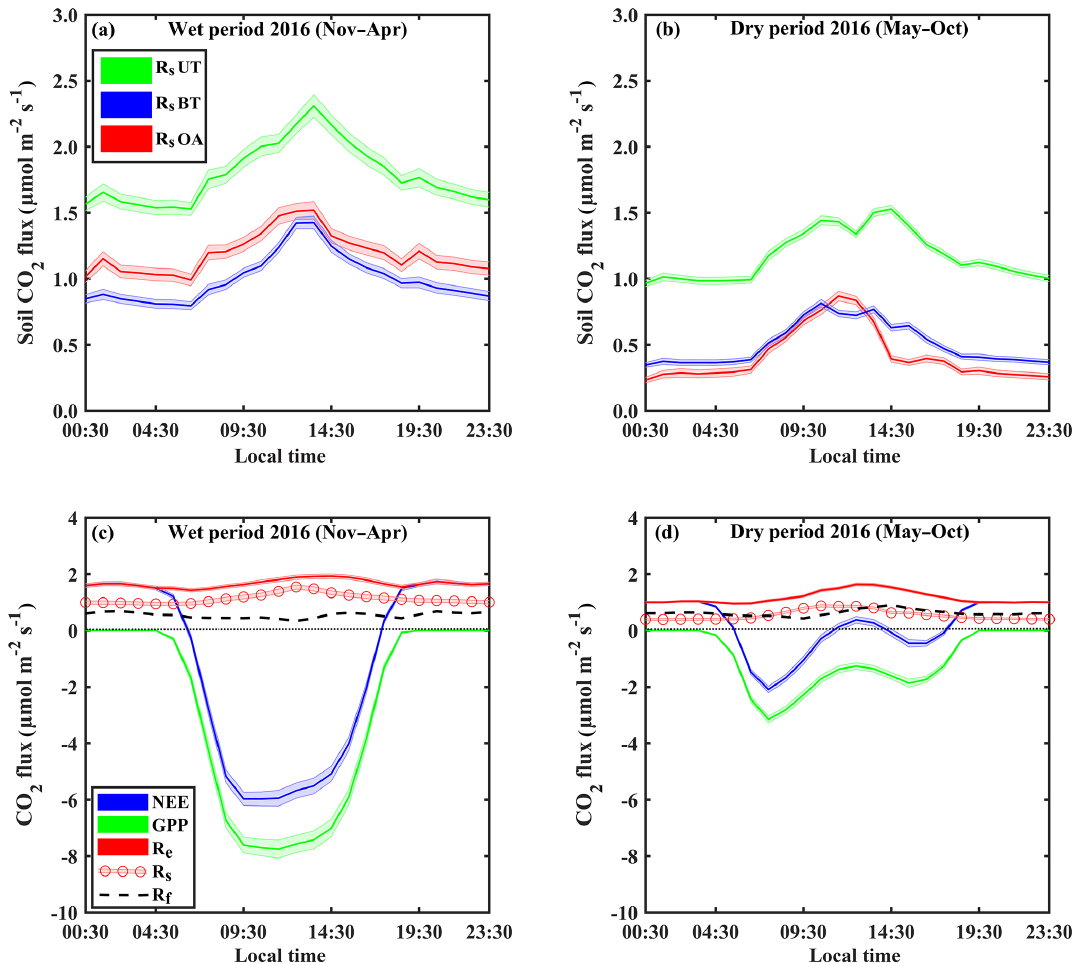
Figure 1. Representative diurnal cycles of soil respiration ( R s ; using soil chambers across locations: open area, OA; between trees, BT; under trees, UT) and sites in panels (a) and (b) , of net ecosystem exchange (NEE; canopy-scale eddy covariance) and gross primary production (GPP) and ecosystem respiration ( R e ) and its partitioning to soil respiration ( R s ) and aboveground tree respiration ( R f ) in panels (c) and (d) , during the wet (November–April) and dry (May–October) periods. Based on half-hourly values over the diurnal cycle; shaded areas indicate ± SE; R = R e − R s and is presented as a dashed line. f was estimated as the residual as R f Table 2. The δ 13 C and (cid:49) 14 C signature of soil respiration ( R s ) and its partitioning into autotrophic ( R sa ), heterotrophic ( R h ), and abiotic ( R i ), together with the relative contribution of each to the soil and ecosystem respiration for Yatir Forest during eight campaigns of measurements from January to September 2016 (numbers in parentheses indicate ± SE) in comparison to results obtained previously in the same forest (2001–2006 mean values). The monthly contribution of R sa , R h , and R i to R s or R e is presented in Fig. 3a and b,